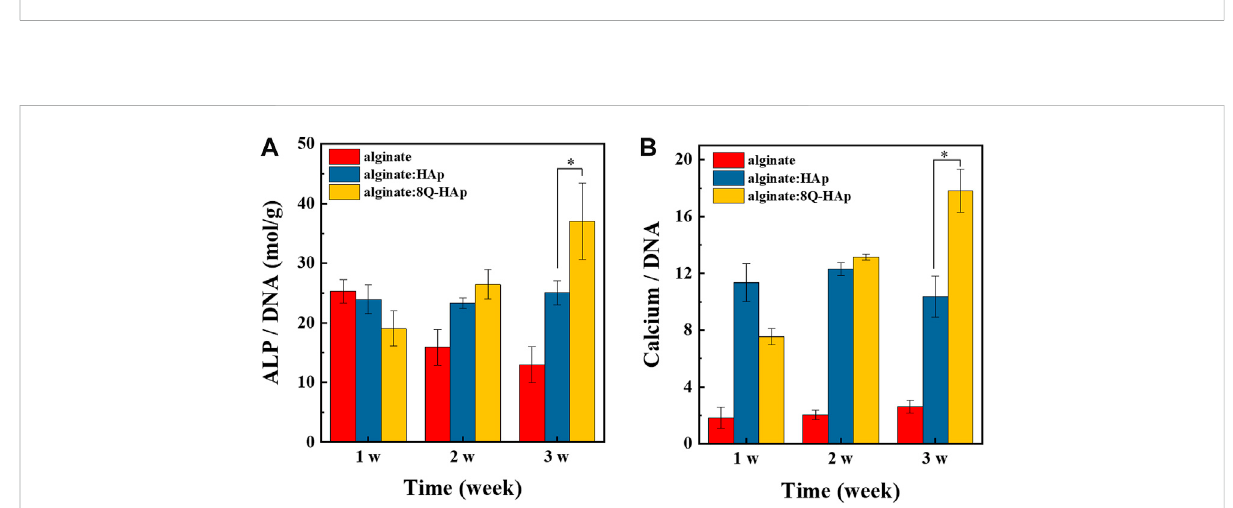
Frontiers in Bioengineering and